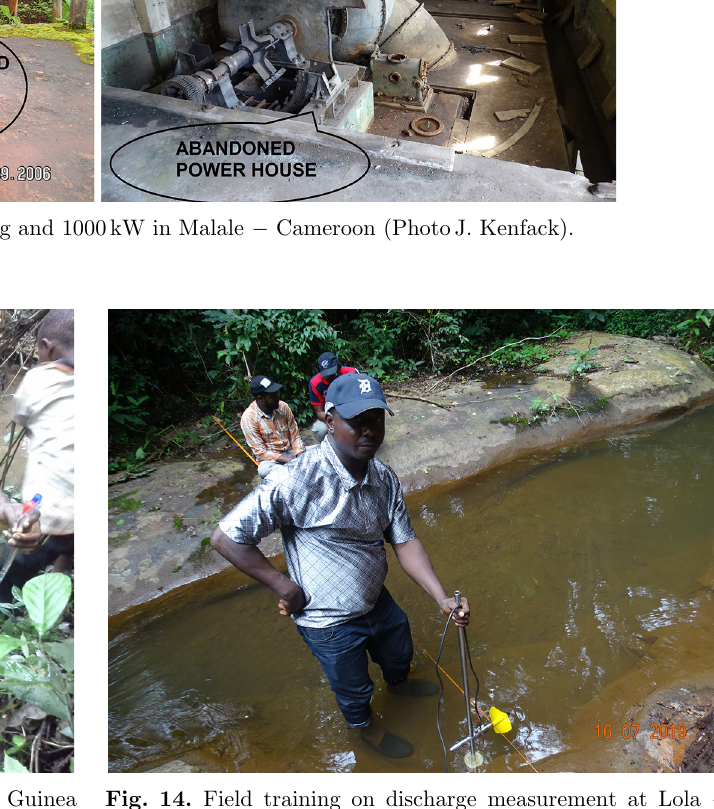
Fig. 14. Field training on discharge measurement at Lola (cid:1) Guinea (Photo J. Kenfack), UNDP